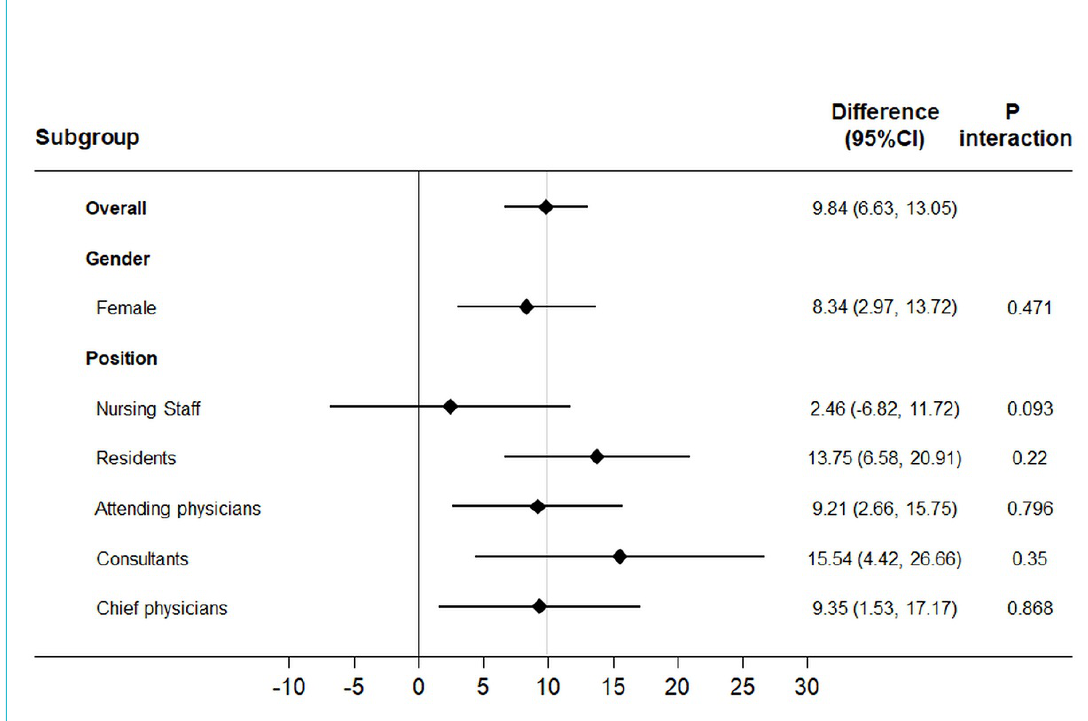
Figure S3: “Feeling insecure during ward round” in different subgroups. All differences calculated with multivariate linear regression models for continuous